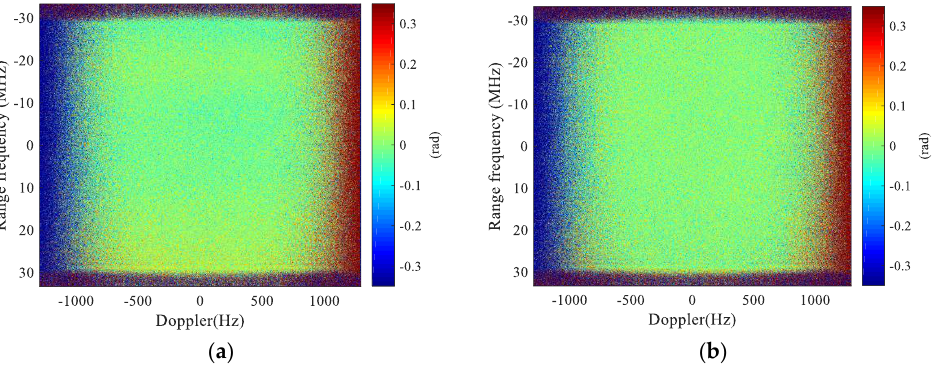
Figure 7. Phase imbalances in the 2-D spectral domain before and after imbalance correction (calibration bandwidths: 60 MHz in range and 1.58 kHz in Doppler): ( a ) before imbalance correction; and ( b ) after imbalance correction.